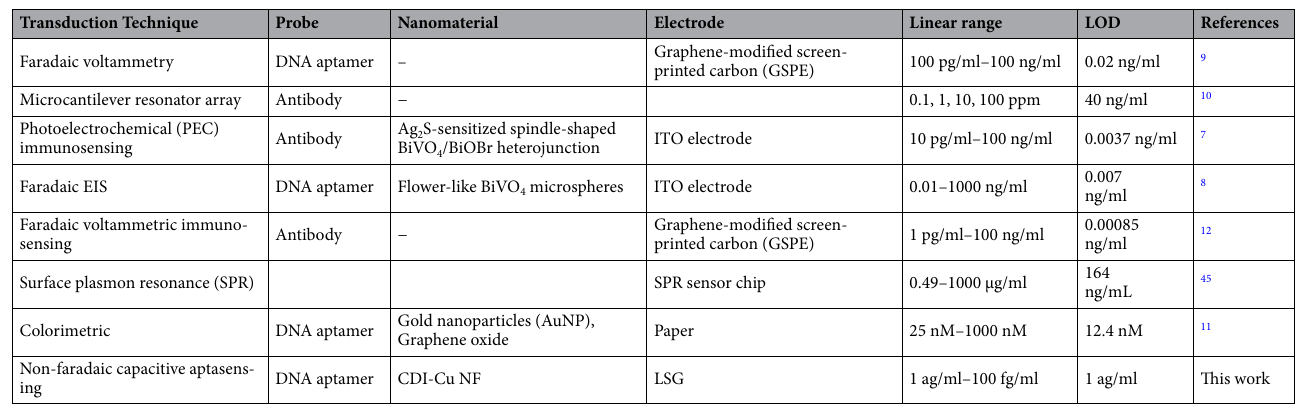
Table 1. Summary of available biosensors for β-lactoglobulin